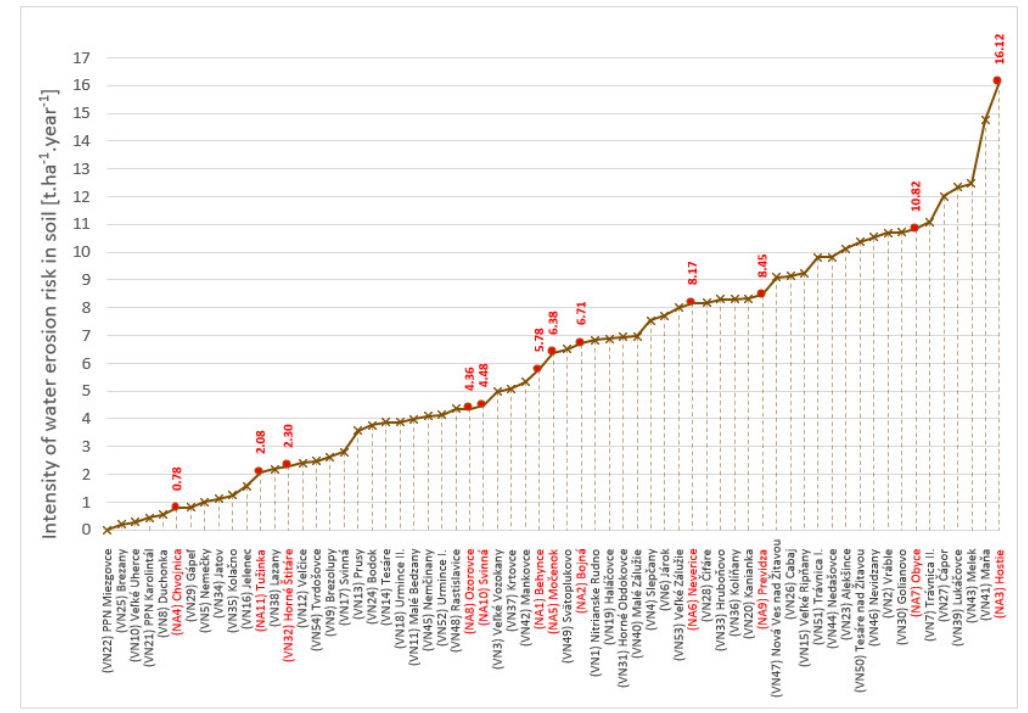
Figure 5. Intensity of water erosion risk in soil.